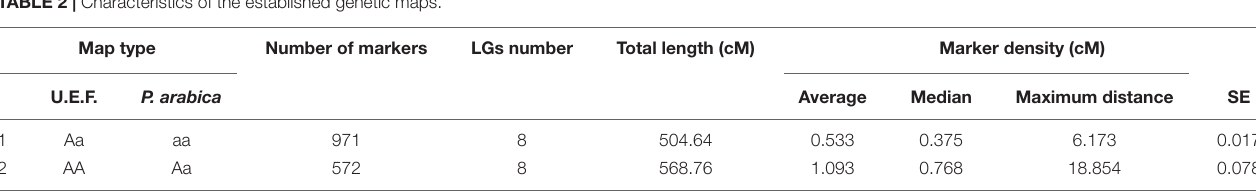
FIGURE 3 | Allelic frequency among the F1 population. Allelic frequency of the heterozygous allele in the F1 population for each marker. Blue line indicates the P. arabica allelic incidence, and red line indicates the U.E.F. allelic incidence. X -axis is the physical position in Mb, and y -axis represents the allelic ratio (from 0 to 1). Black arrow in chromosome 3 represents an example of unexpected deviated region (“hot spot”). References lines presented the “tolerance interval” limits. TABLE 2 | Characteristics of the established genetic maps.